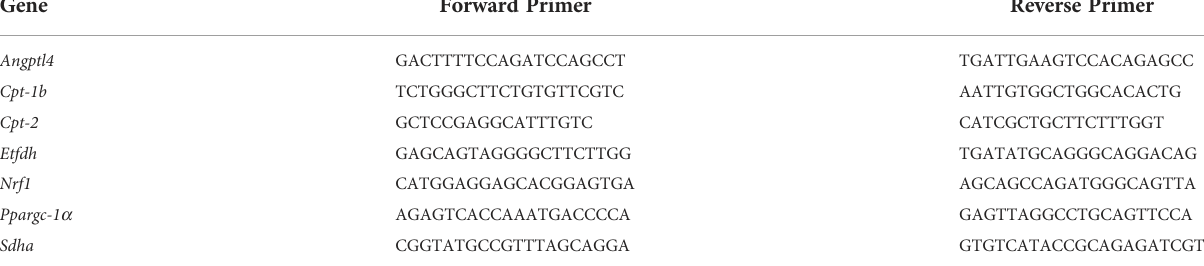
TABLE 1 Primer sequences used for gene ampli fi cation